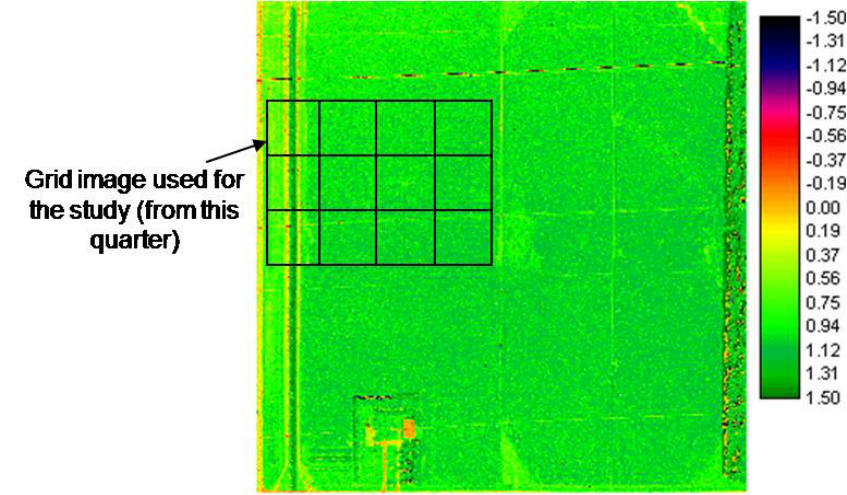
Figure 7. Soil adjusted vegetation index (SAVI) image of the OITA SW16 quarter of 1999.